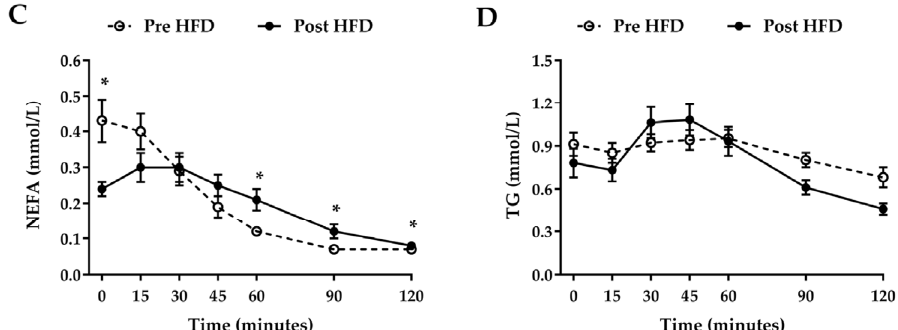
Figure 1. Systemic plasma glucose ( A ), serum insulin ( B ), plasma non-esterified fatty acid (NEFA) ( C ), and plasma triglyceride (TG) ( D ) concentrations during a 2-h oral glucose tolerance test (OGTT) conducted before (pre) and after (post) one day of high-fat overfeeding (HFD). Data presented are means ± standard error of the mean (SEM). n = 15. * p < 0.05 significant difference between trials at the annotated time point. # p < 0.05 denotes significant main effect of trial/high-fat overfeeding.